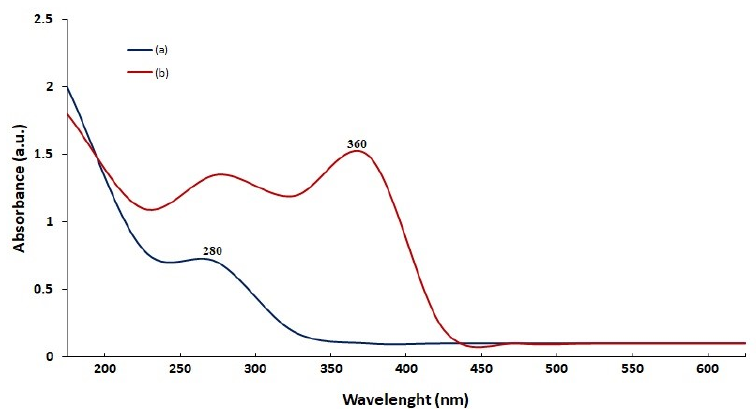
Figure 1. The UV-Vis absorption spectra of Phlomis leaf extract ( a ) and synthesized zinc oxide nanoparticles ( b ).